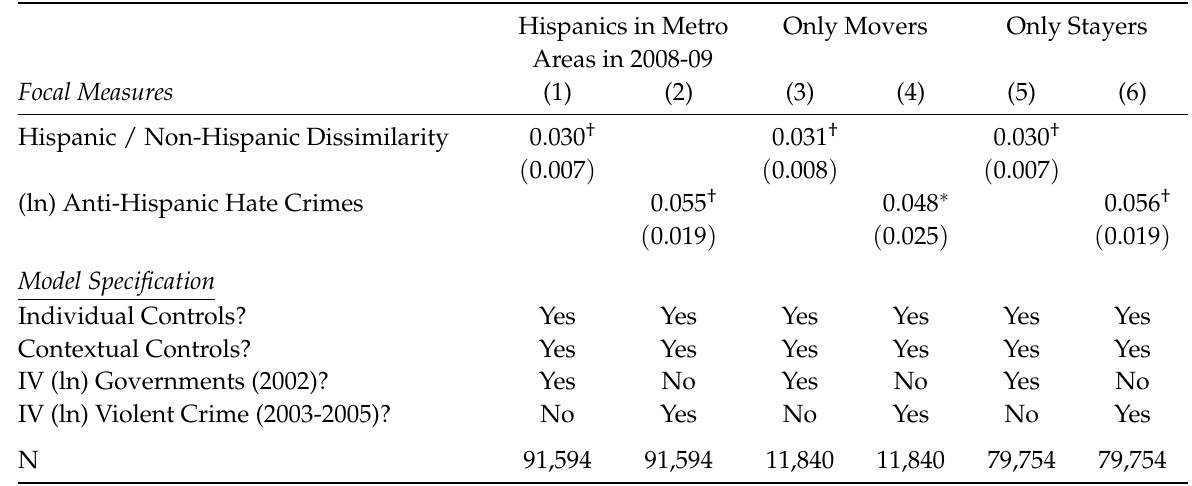
Table 4: Sensitivity Analyses: IV Probit Estimates of Hispanic ’Other Race’ Identification by Mobility Patterns, American Community Survey